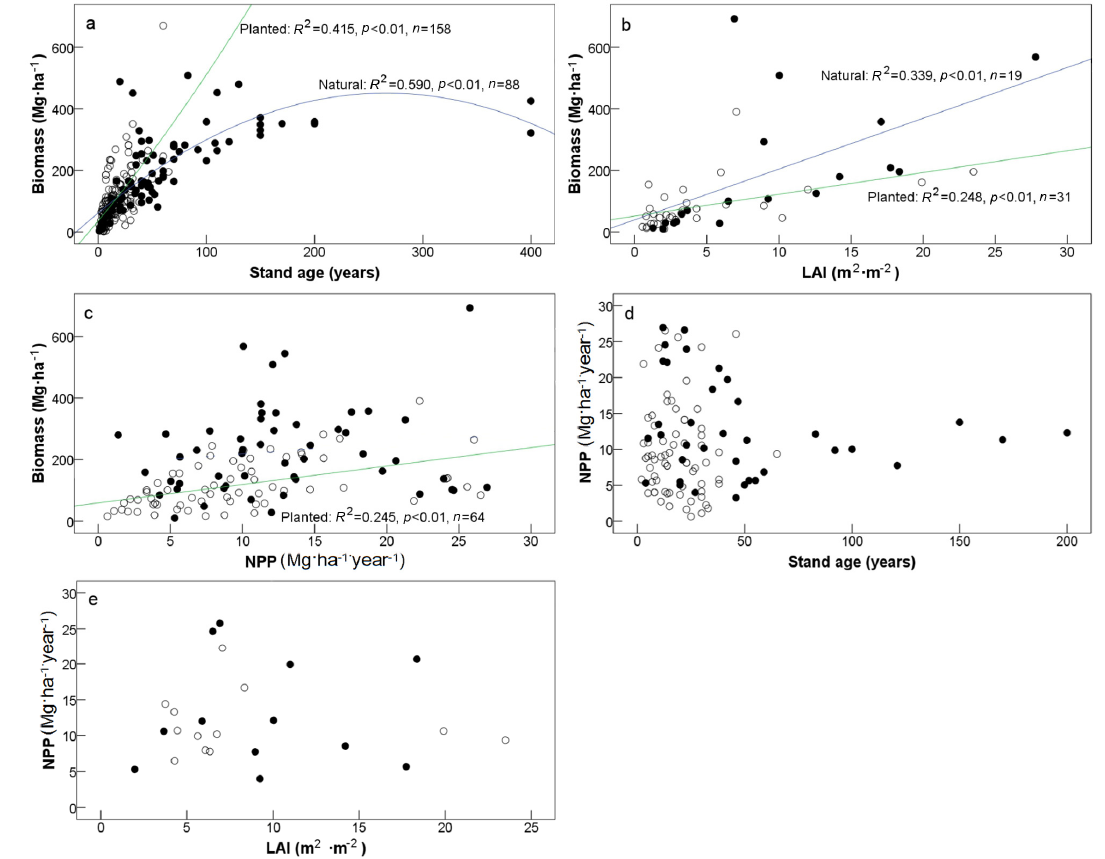
Figure 7. Relationships among biomass, NPP, and stand characteristics. Dots: biomass/NPP of natural forests; cycles: biomass/NPP of planted forests. ( a ) Biomass and stand age; ( b ) biomass and LAI; ( c ) biomass and NPP; ( d ) NPP and stand age; ( e ) NPP and LAI.